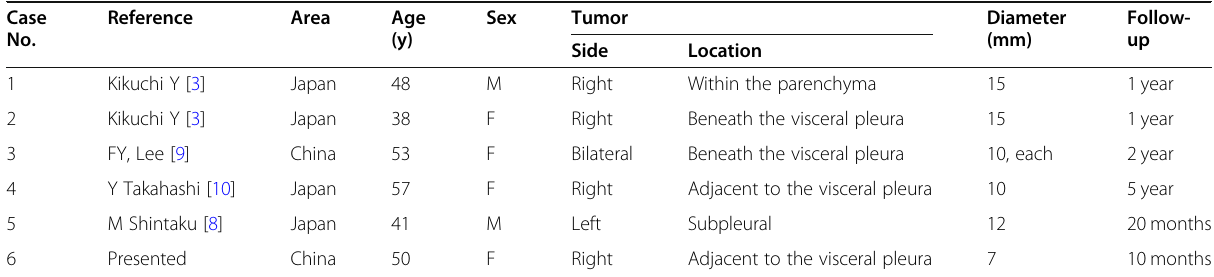
Table 1 Clinical Features of the six reported lung BNCTs Case